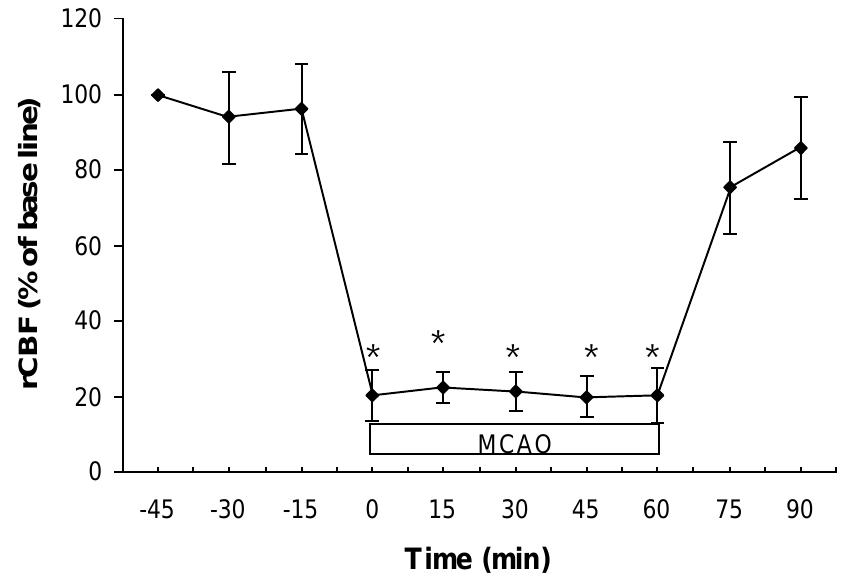
FIGURE 1 . rCBF before and during MCAO, and after reperfusion (*; p = 0.000, n =